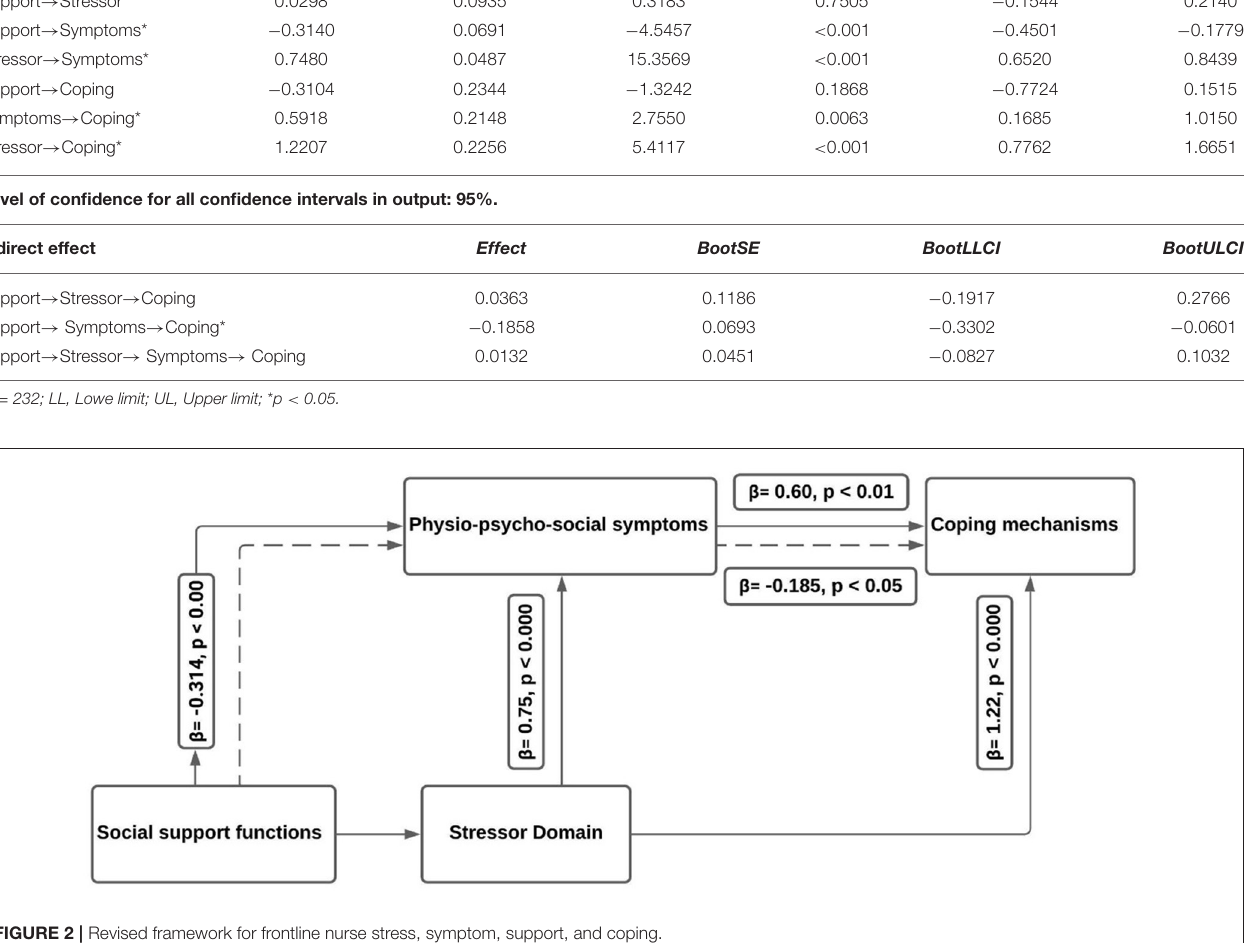
FIGURE 2 | Revised framework for frontline nurse stress, symptom, support, and